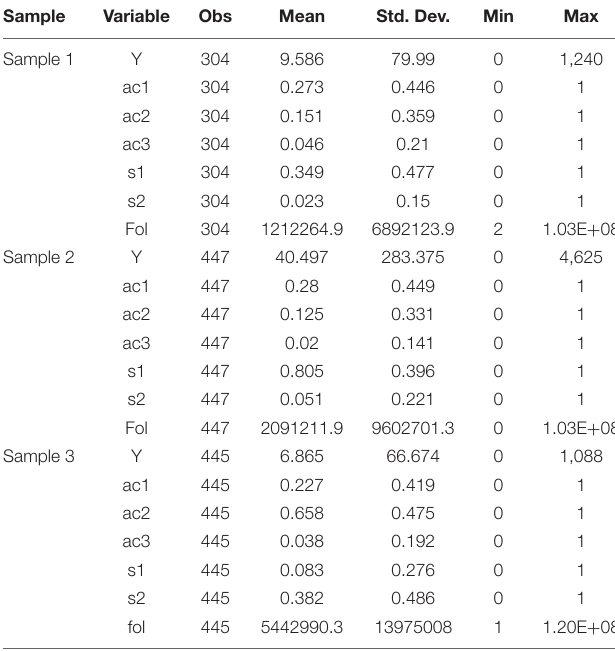
TABLE 1 | Descriptive statistics of the major